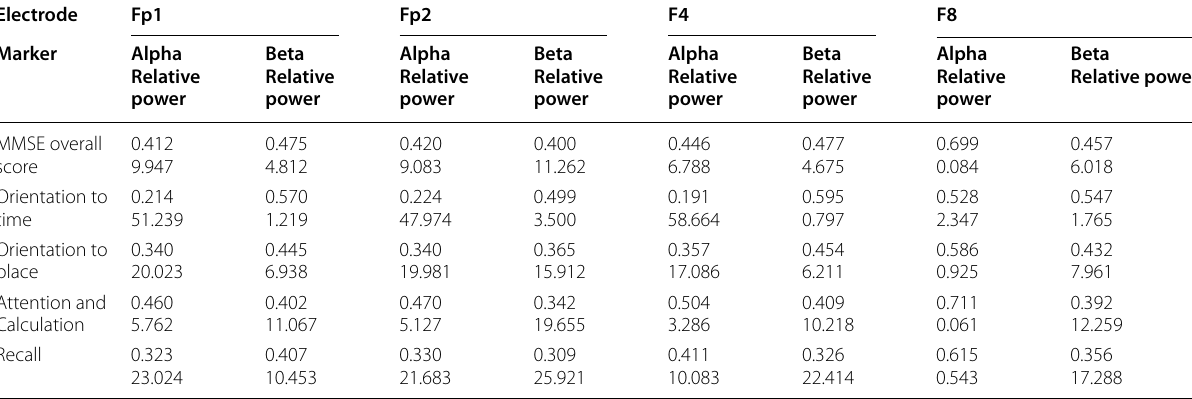
Bold number means positive correlation. First line of each cell represents the Pearson correlation coefficient, and second line represents corrected p -value by multiplying by 280 Table 5 Results of study on correlations between MMSE scores and alpha, and beta relative powers recorded from Fp1, Fp2, F4, and F8